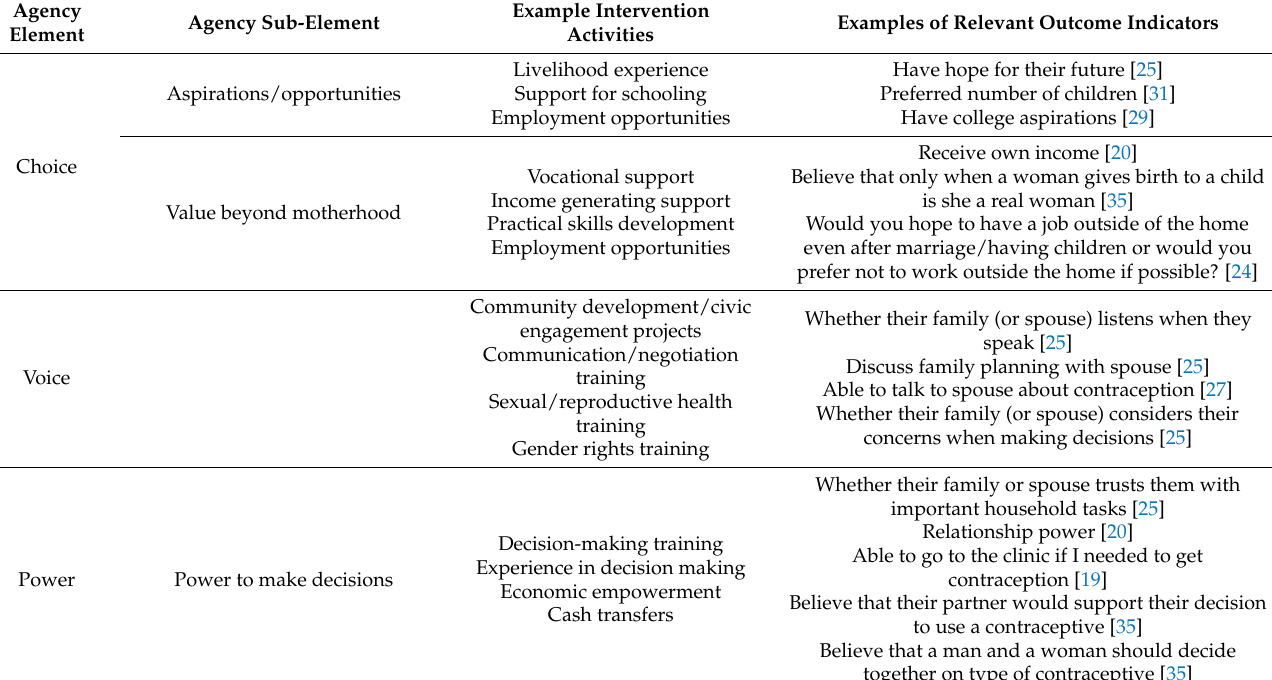
Table 4. Summary of intervention activities targeting adolescent girls to increase their agency, and example